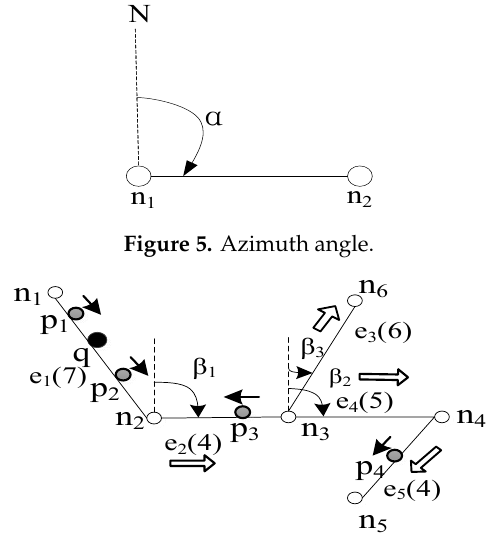
Figure 6. Azimuth angle of road network expansion.